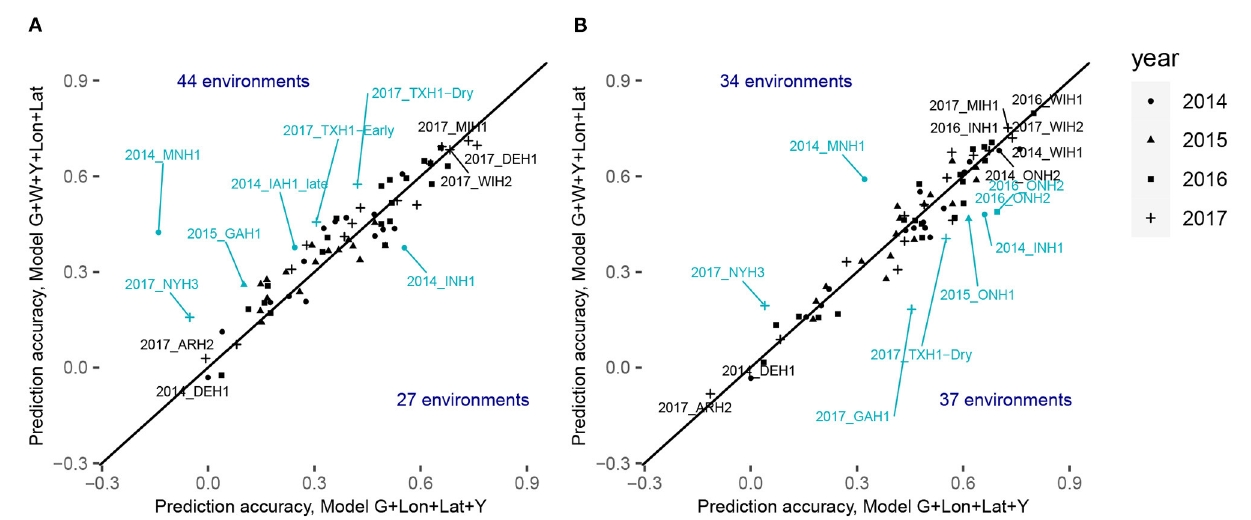
FIGURE 5 | Comparison of the within-environment predictive ability with different sets of predictors for the trait grain yield for XGBoost (A) with the CV0-Year scenario and (B) CV0-Site scenario. The x-axis corresponds to the within-environment correlation obtained with the model incorporating PCs derived from SNPs, year and geographical coordinates. The y-axis corresponds to the within-environment correlation obtained with the model incorporating PCs, year, W (i.e., weather- and soil-based covariates) and geographical coordinates. The line indicates the identity. Blue-colored points with a label indicate environments for which the absolute difference between the two predictive abilities was superior to 0.13. Black-colored points with a label indicate the least and the most accurately predicted